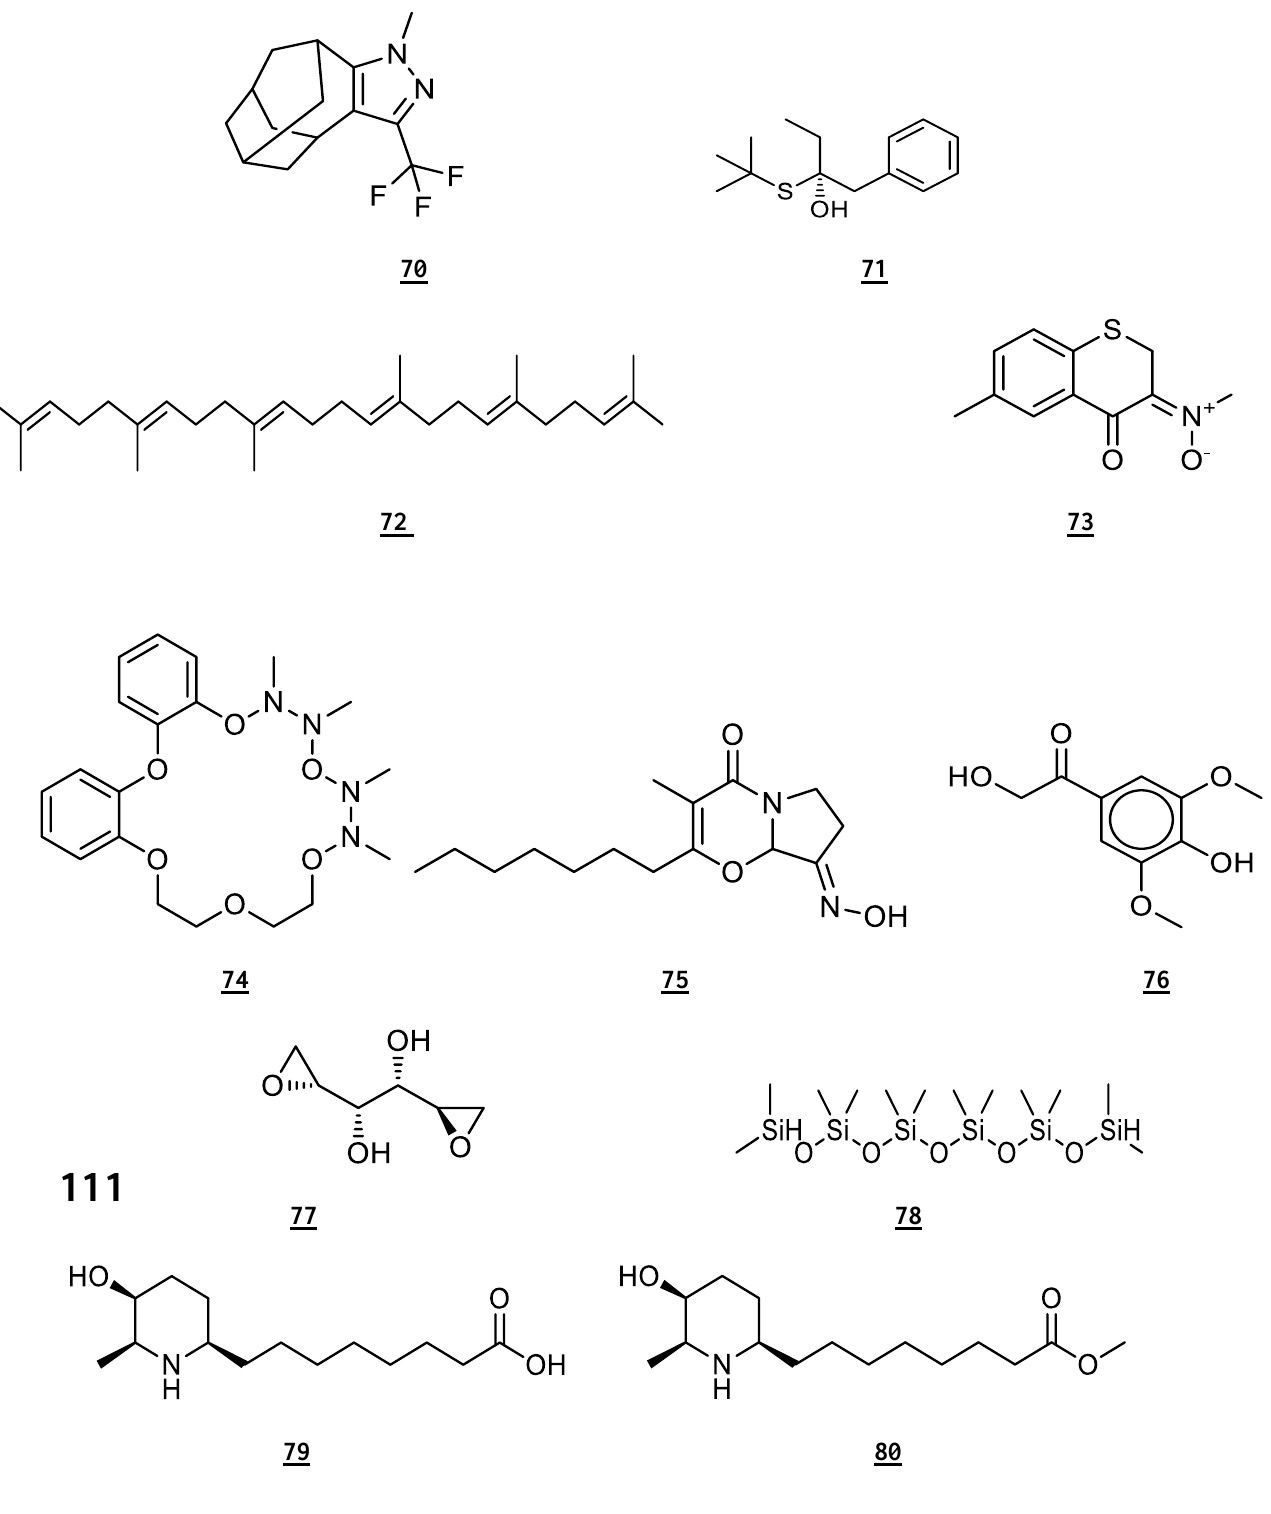
Fig. 4. Chemical structures of miscellaneous compounds isolated form C.